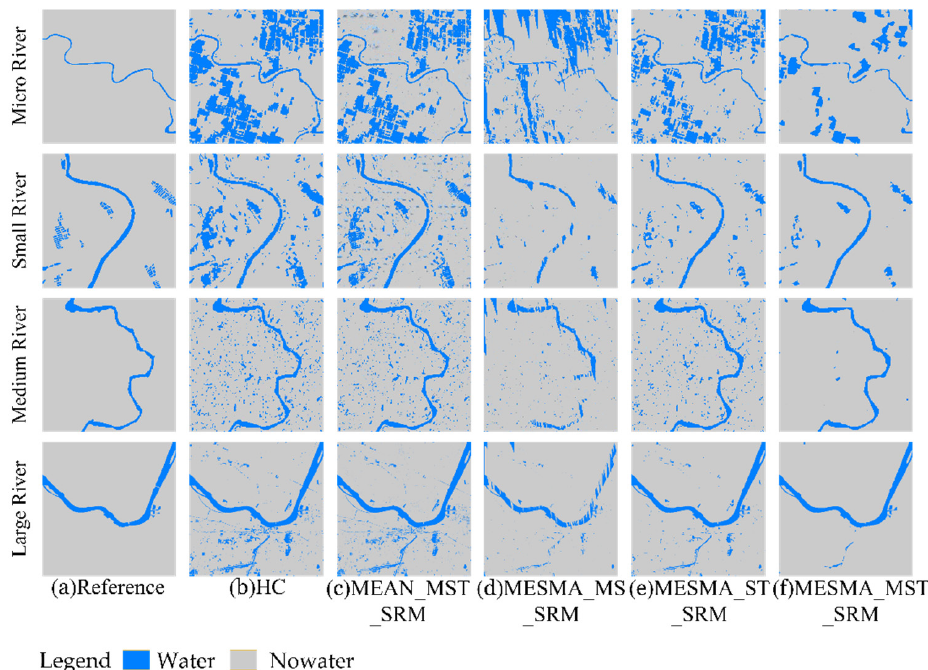
Figure 3. Comparison of the resultant water body maps for different ribbon-like bodies of water: ( a ) reference water body map; ( b ) water body map generated by the HC method; ( c ) water body map generated by the MEAN_MST_SRM method; ( d ) water body map generated by the MESMA_MS_SRM method; ( e ) water body map generated by the MESMA_ST_SRM method; ( f ) water body map generated by the MESMA_MST_SRM method.